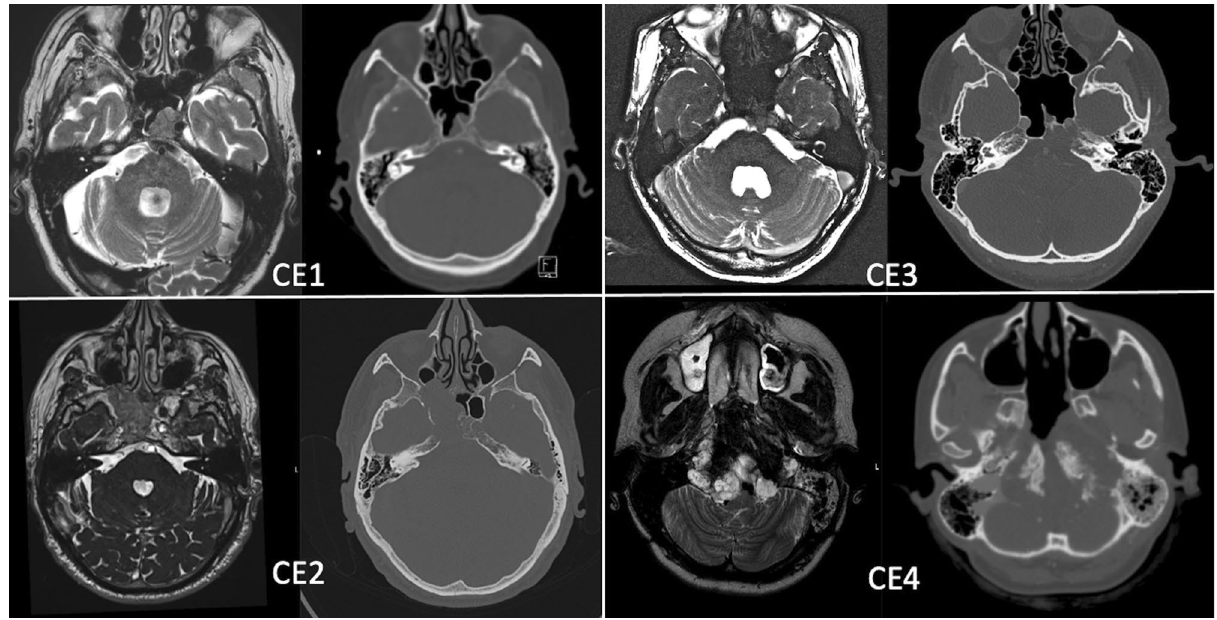
Figure 1. Clival extent classification (CE) with various extent categories: CE1: Intraosseous lesion, CE2: Destruction of the osseous clival cortical bone, CE3: Brainstem reached without compression or infiltration, CE4: Compression/infiltration of the